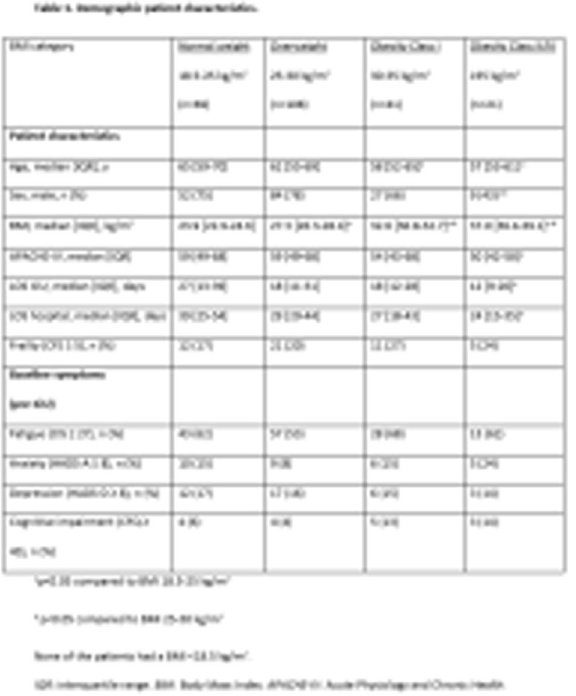
Table 1. Demographic patient characteristics